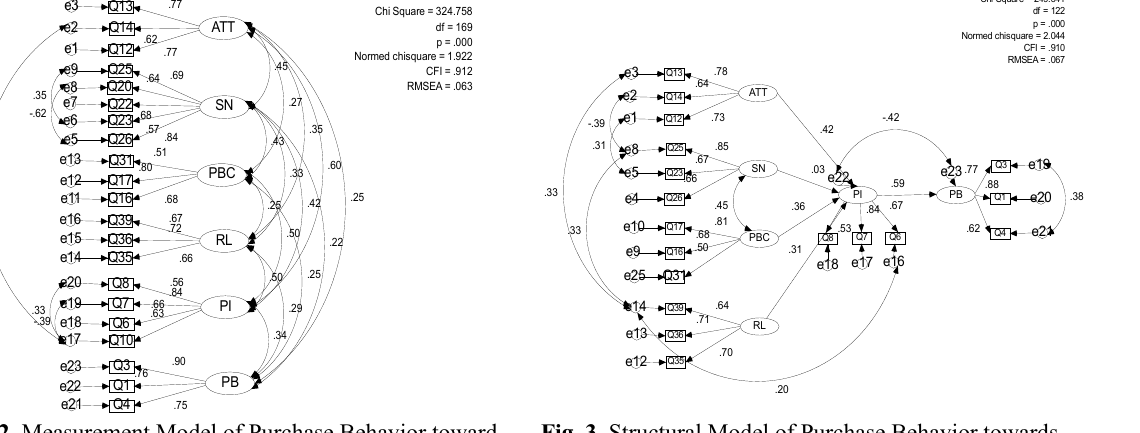
Fig. 3. Structural Model of Purchase Behavior towards Halal Cosmetic